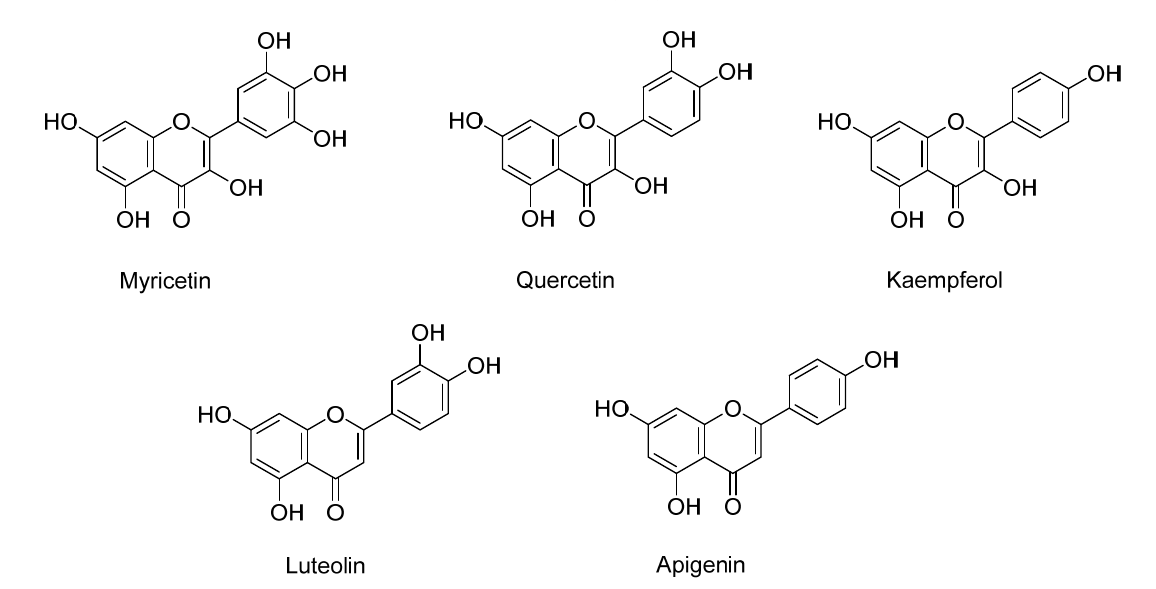
Figure 1. The main flavonoids identified in sweet potato.